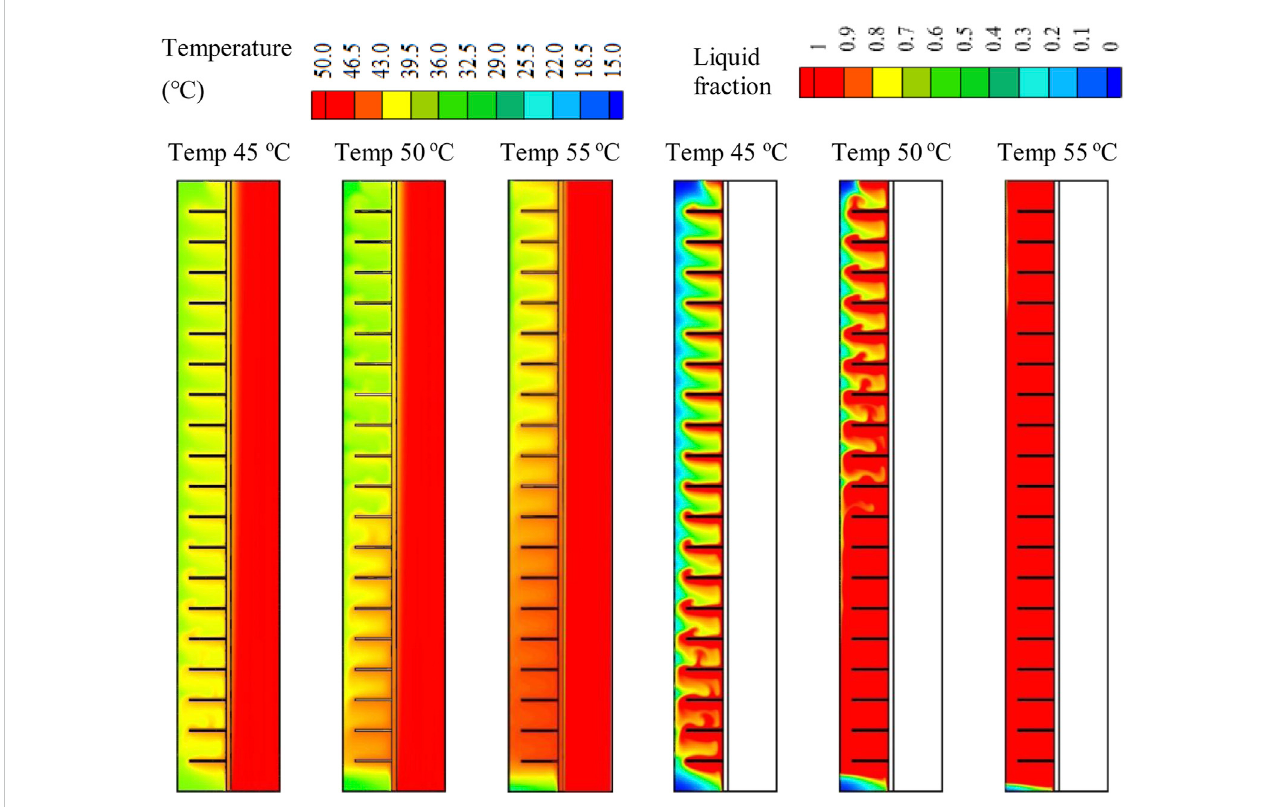
FIGURE 14 The melting process and temperature distribution of the PCM with various HTF inlet temperatures at 3,600